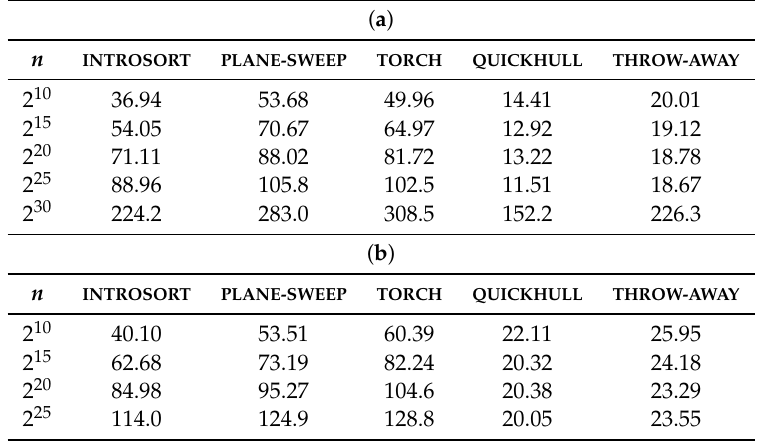
Table 7. The running time of the competitors [in nanoseconds per point] for the bell data set: ( a ) Linux computer, ( b ) Windows